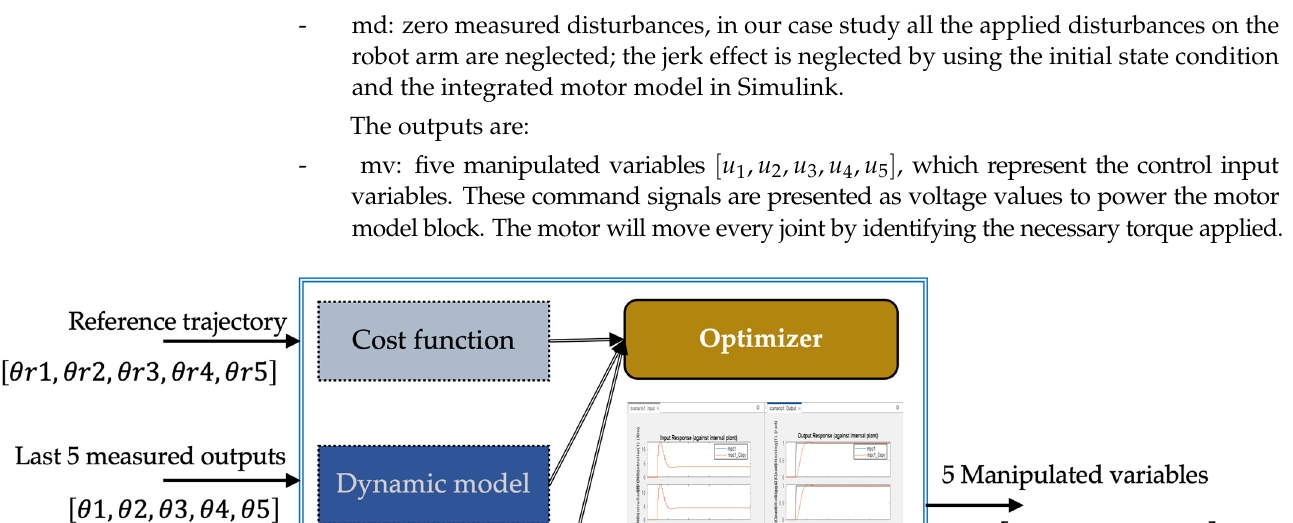
Table 5. MPC parameters relating to the RV-2AJ robot